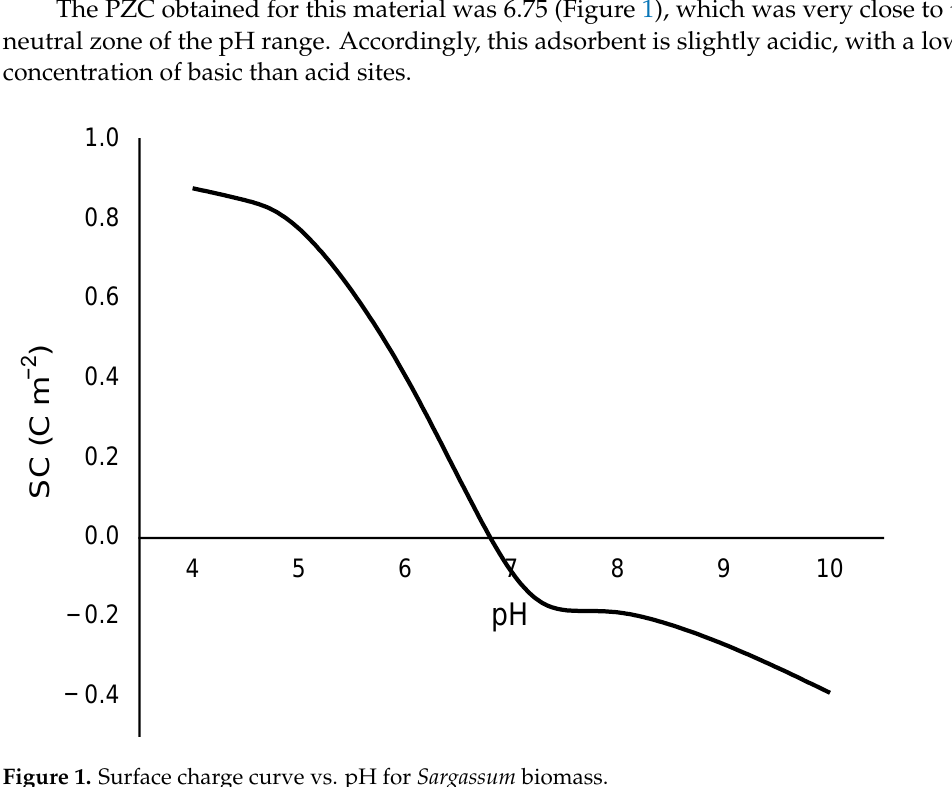
Figure 1. Surface charge curve vs. pH for Sargassum biomass.